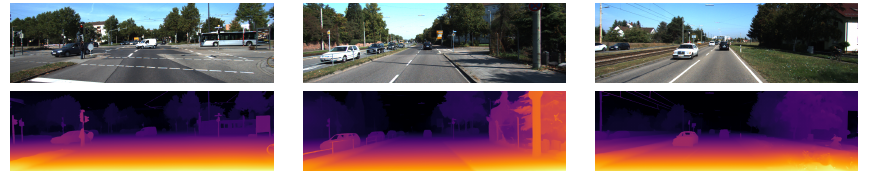
Figure 3. The qualitative results from [27] show the left RGB images from 3 scenes in the KITTI-2015 stereo dataset in the top row and the corresponding disparity map predictions in the bottom row are shown using colour to represent the disparity